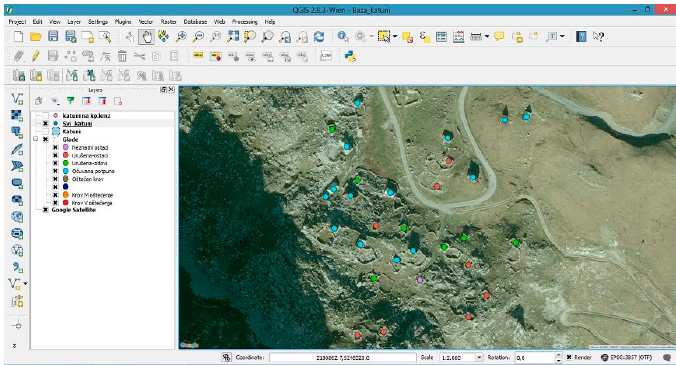
Figure 2. Overview of katun in database—Širokar, Google satellite imagery, entry by O. Pelcer-Vuja č i ć .